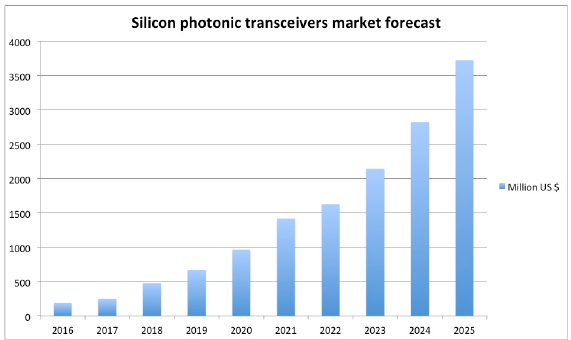
Figure 1. Silicon photonics 2016–2025 market forecast [1].